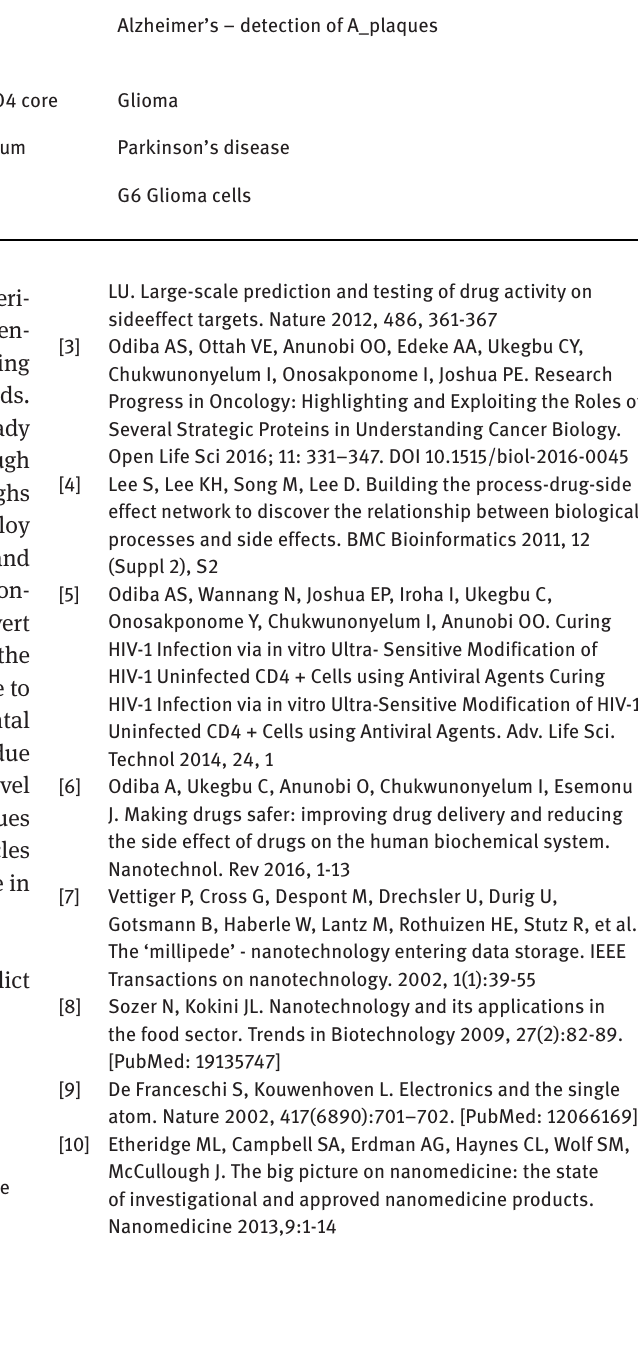
Drug Nano-drug Target/action 5-chloro-7-iodo-8- Polymeric encapsulation Cu/Zn chelator – Alzheimer’s hydroxyquinoline CQ [112]